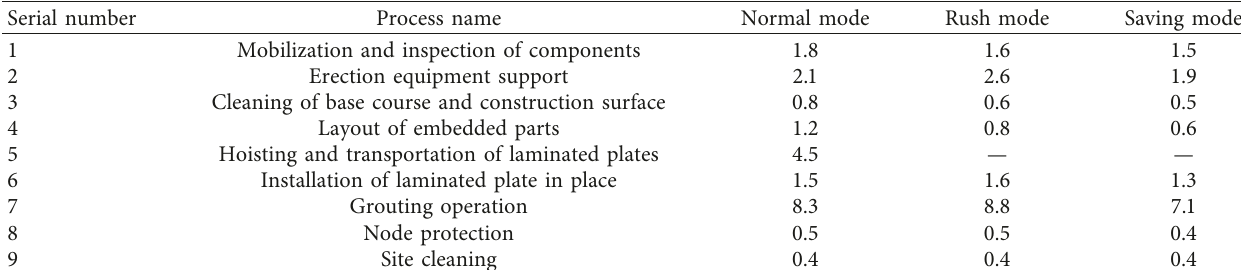
Table 5: Summary of carbon emission data in installation process of laminated plate components (kg).